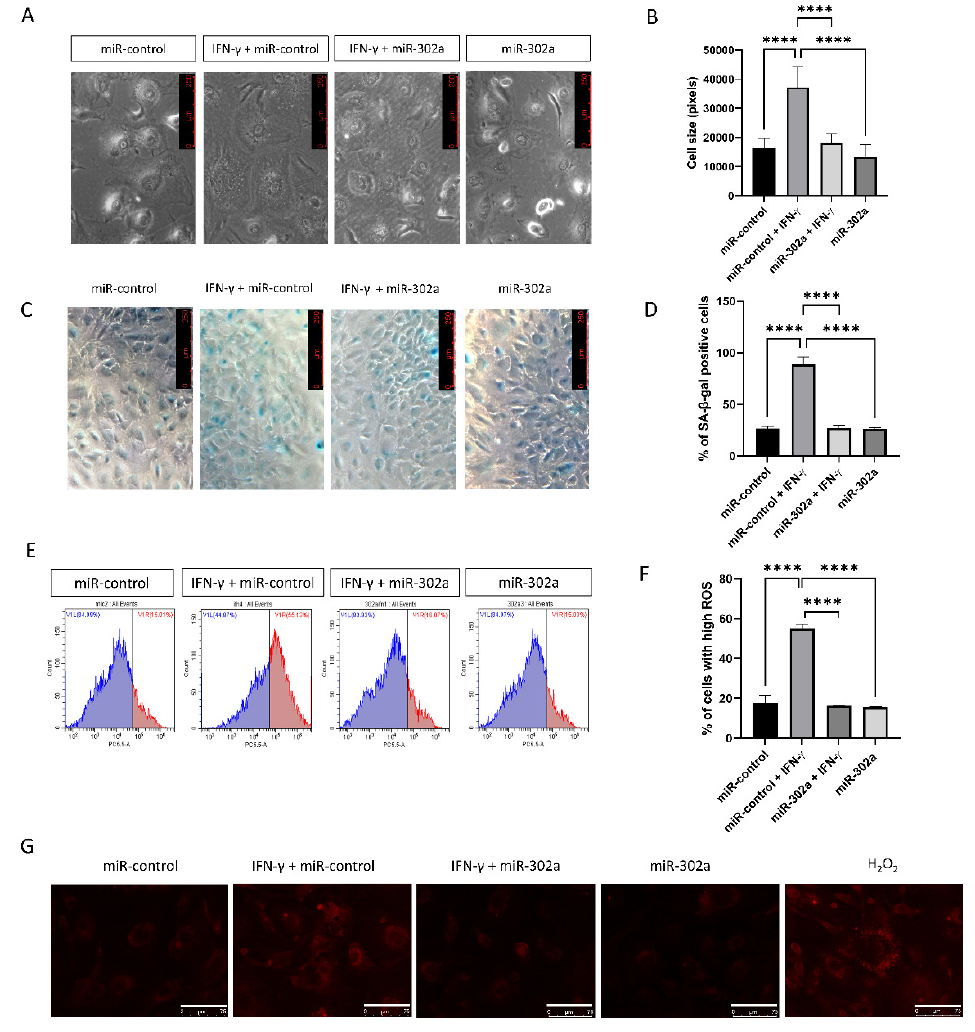
Figure 2. Effect of miR-302a on senescence. ( A , B ) Cell size was evaluated in miR-control and miR- 302a with or without interferon- γ (IFN- γ ). Scale bar = 250 µ m. ( C , D ) Senescence- β -galactosidase staining was performed and blue staining indicated the senescence- β -galactosidase staining positivity. ( E – G ) Mitochondrial oxidative stress levels were measured using MitoSOX probe. Scale bar = 75 µ m. Data presented as mean ± S.D. **** p <